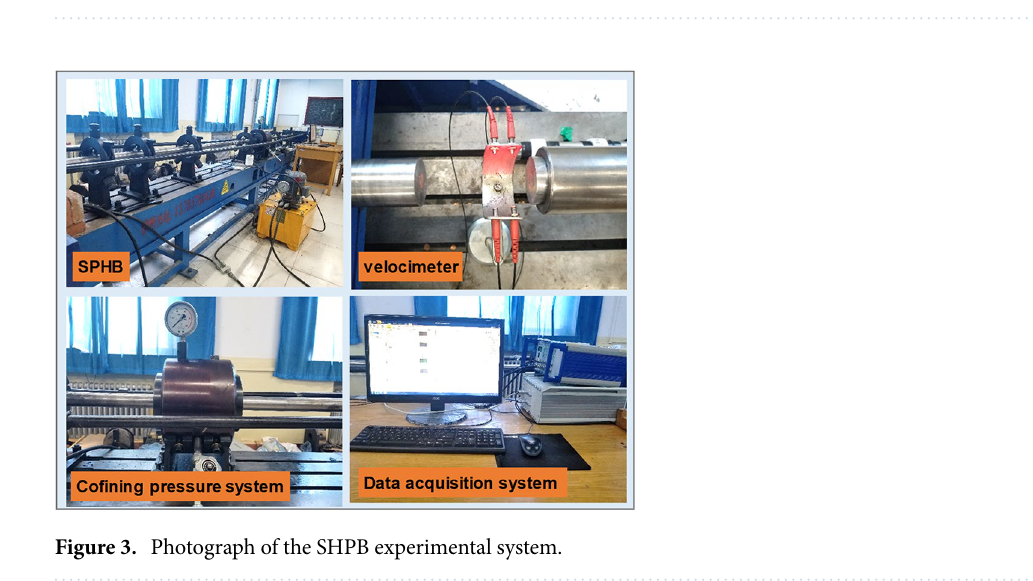
Figure 2. Schematic of general SHPB experimental system.